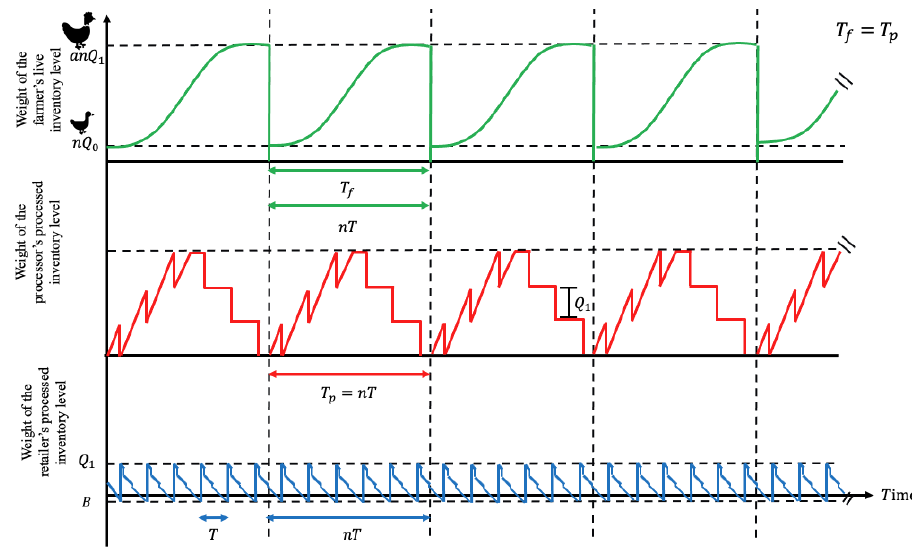
T nT = . T . The growth f